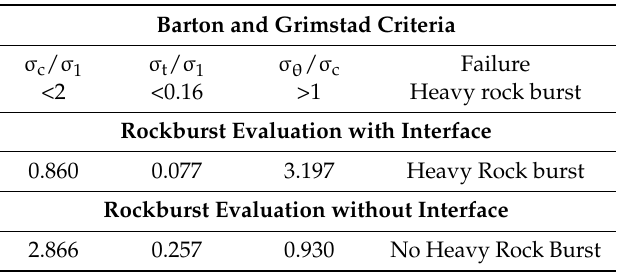
Table 3. Empirical rockburst evaluation based on Barton and Grimstad criteria .